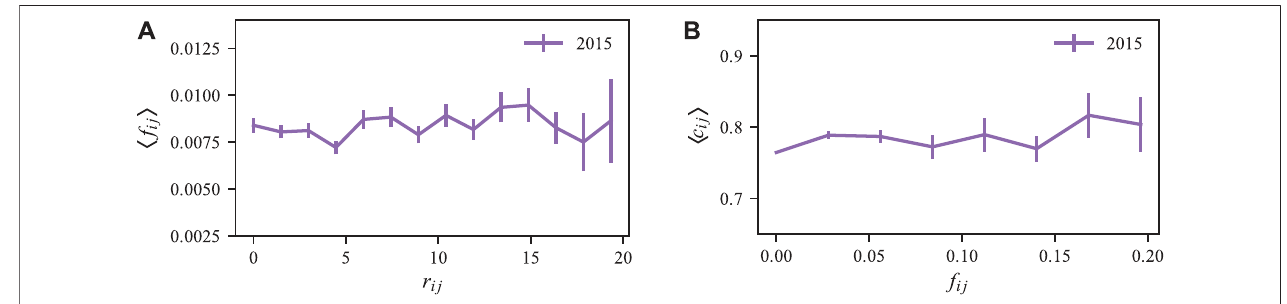
FIGURE 6 | Spatio-temporal characteristics of human mobility between neighborhoods. (A) Average neighborhood-neighborhood fl ux 〈 f ij 〉 as a function of the distance r ij between neighborhoods i and j for the year of 2015. As shown, the rate fl ux of bus trips between neighborhoods of Fortaleza is independent of the distance between the neighborhoods. (B) The right panel shows the spatio-temporal correlations 〈 c ij 〉 with τ = 0 as a function of the neighborhood-neighborhood fl ux f ij for the year of 2015. As presented, the spatio-temporal correlations of dengue cases have no signi fi cant dependence on f ij . In both panels, the bars are the standard